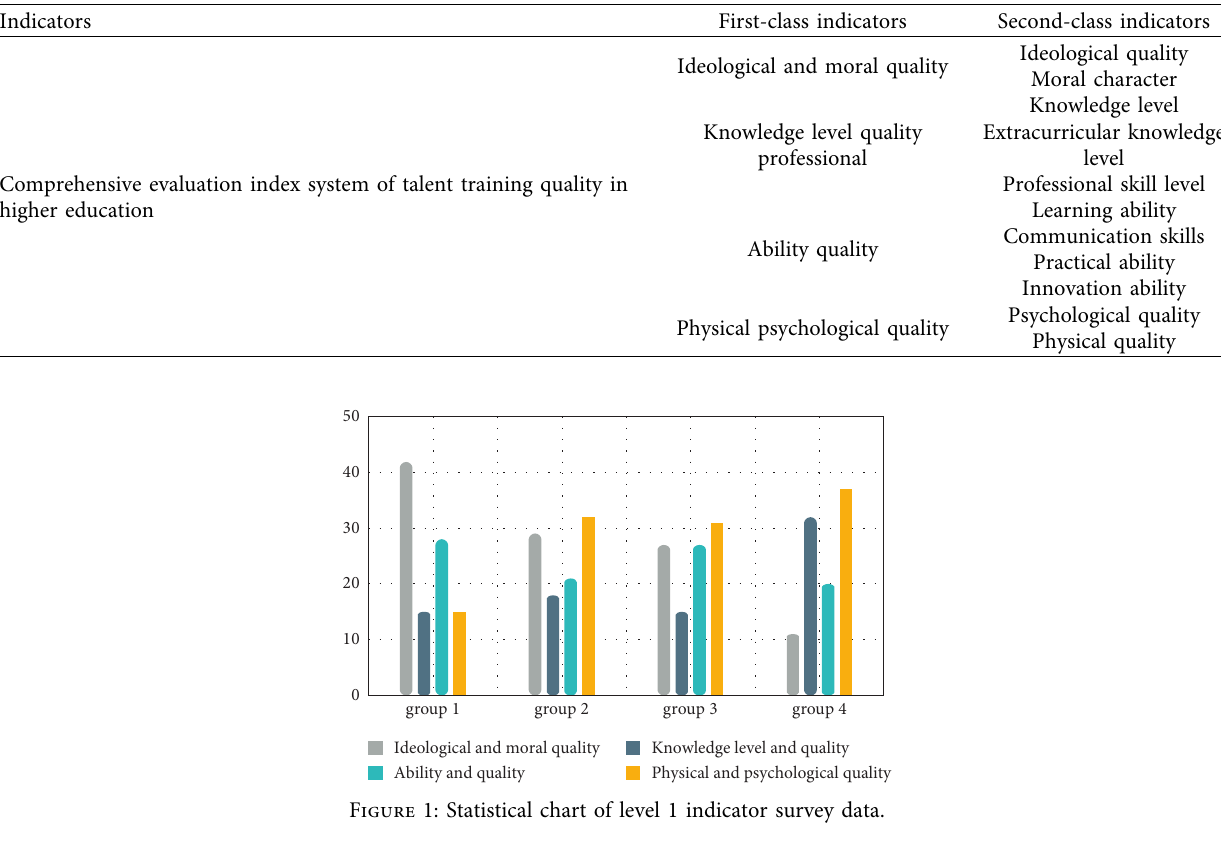
Table 1: Comprehensive evaluation index system of talent training quality in higher education.